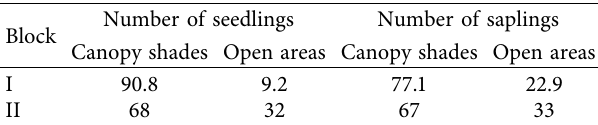
Table 5: Seedlings and saplings of P. falcatus under canopy shades and in open areas.